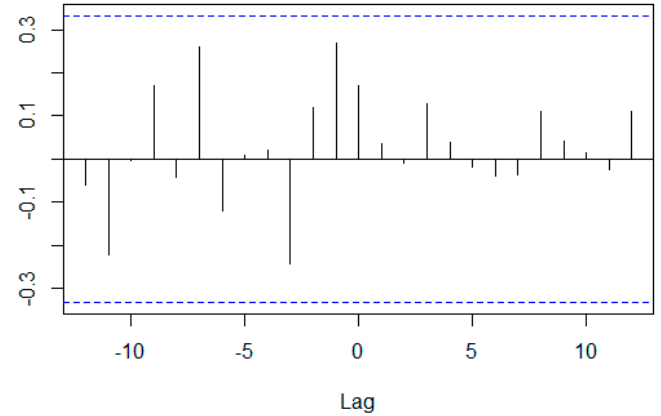
Figure 16. Cross-correlation coefficient between the average BHAR of the camera group and the average BHAR of the display group for Jan 2010–Dec 2012.